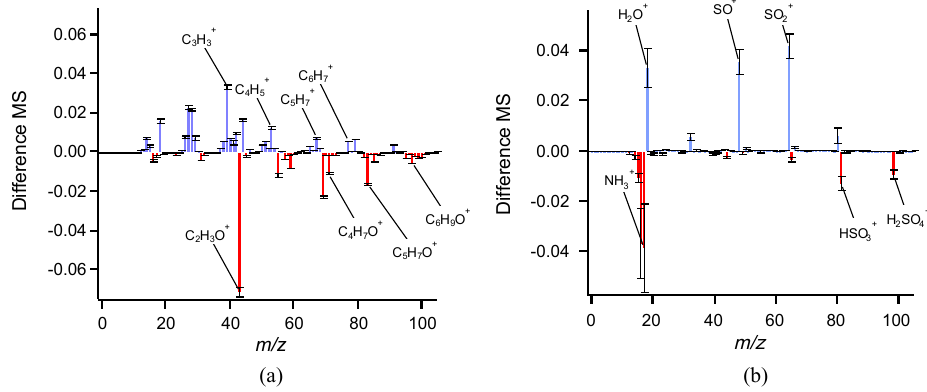
Figure 10. Difference plots between prompt and delayed average mass spectra for (a) SOA and (b) ammonium sulfate. Plot is prepared by first normalizing each spectrum by the total signal and then subtracting the normalized delayed MS from the normalized prompt MS. Thus, mass fragments with positive values (blue) are enriched in the prompt MS, and those with negative values (red) are enriched in the delayed MS. Error bars are the propagated standard errors of the mean for each